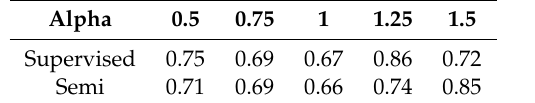
Table 10. Sensitivity Analysis (Alpha).